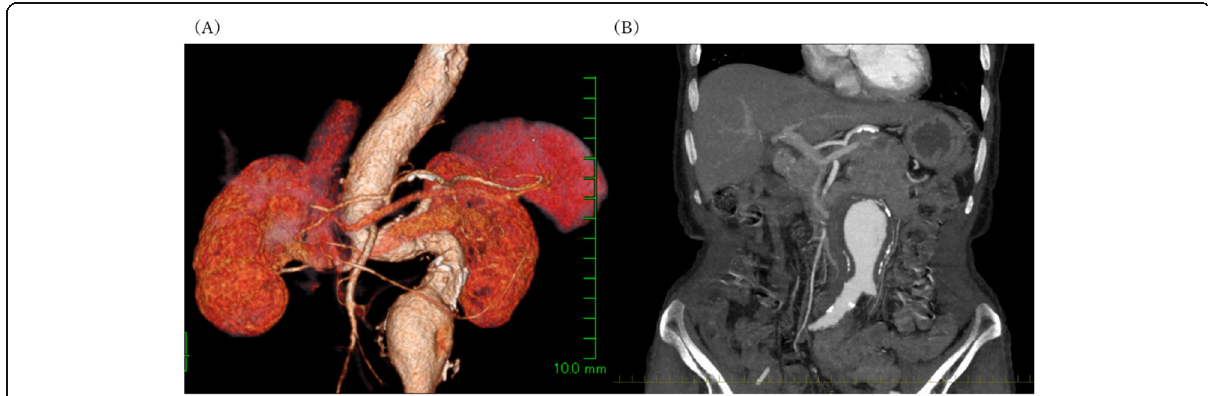
Fig. 1 Preoperative computed tomography. A An aneurism, 47 mm in diameter, under the renal artery. B The aneurism contained a thick intramural thrombus and the lumbar arteries were almost